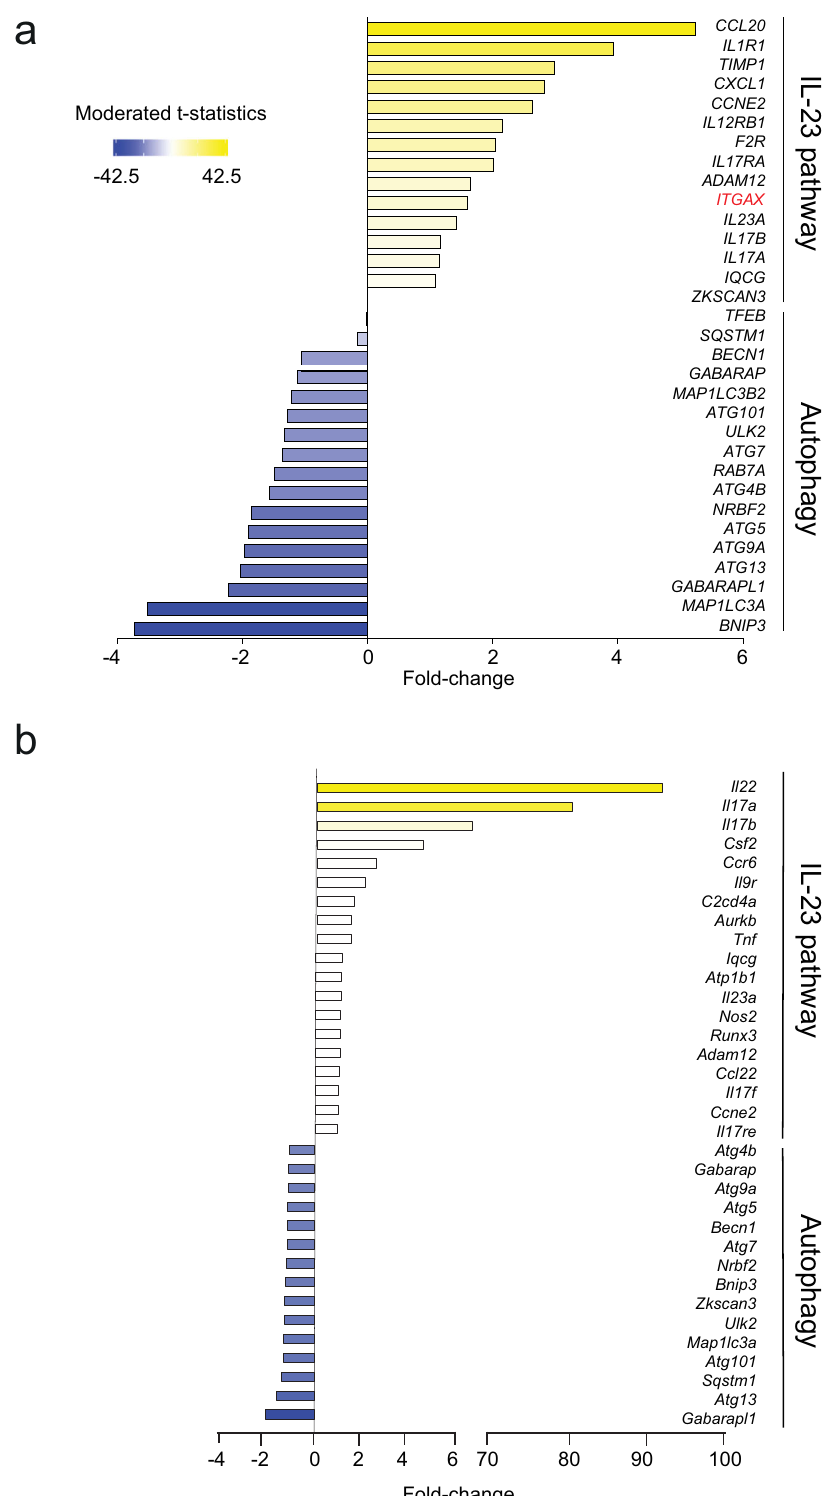
Fig. 1 Autophagy genes are inhibited in human and mouse livers in lipid-rich contexts. a Color-coded histogram of the expression levels of genes associated with the IL-23 pathway or the autophagy mechanism. The genes are shown as their moderated t -statistic value which is calculated based on the fold-change between patients with advanced NAFLD compared to mild cases. Transcriptome data was obtained and reanalyzed for 72 patients (40 patients with mild NAFLD and 32 patients with advanced NAFLD). b Color-coded histogram of the expression levels of genes associated with the IL-23 pathway or the autophagy mechanism. The genes are shown as their fold-change values between WT mice fed NCD or HFD for 7 weeks ( n =